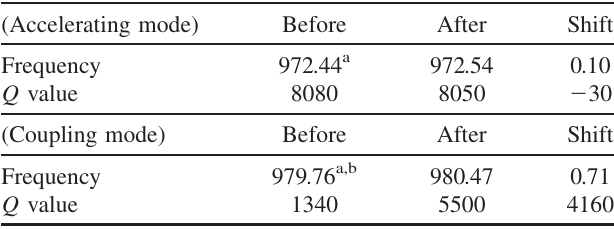
TABLE IV. Frequency shift due to the test brazing. Two half- cell pieces were brazed as shown in Fig. 5. The frequency was corrected to that of the vacuum condition at the operating temperature of 27 (cid:2) C (see Appendix B) (unit: